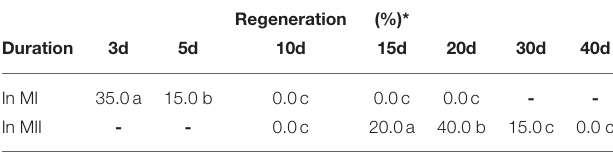
TABLE 6 | Effect of culture duration in MI and MII media on protoplast regeneration of rapeseed. Regeneration